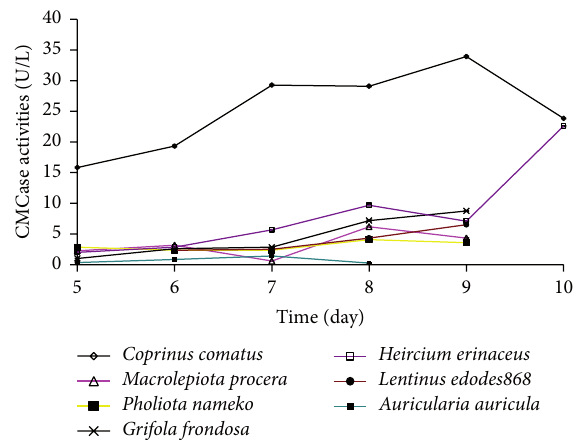
Figure 2: Time courses of CMCase activity of 7 strains. Five mycelium agar discs (5mm diameter) were used as the inoculum. Cultivated in CMC liquid medium, 1mL Zymotic fluid of the strains wastakenoutoftheflaskforexperimenteachday.Thedatarepresent the average of three independent experiments.